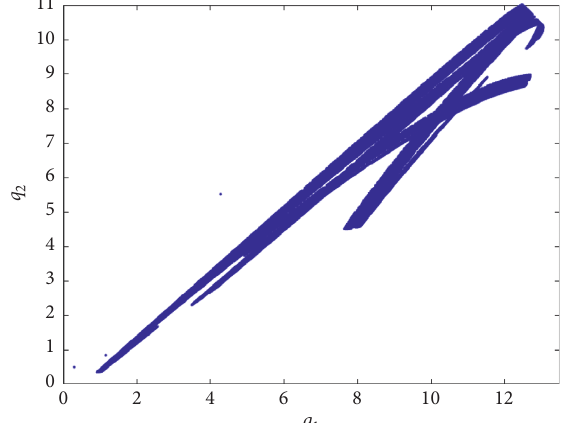
Figure 2: Strange attractor of the chaotic state of duopoly game (12), with the parameter values a � 6 , b � 0 . 3 , c β � 0 . 9, and k �